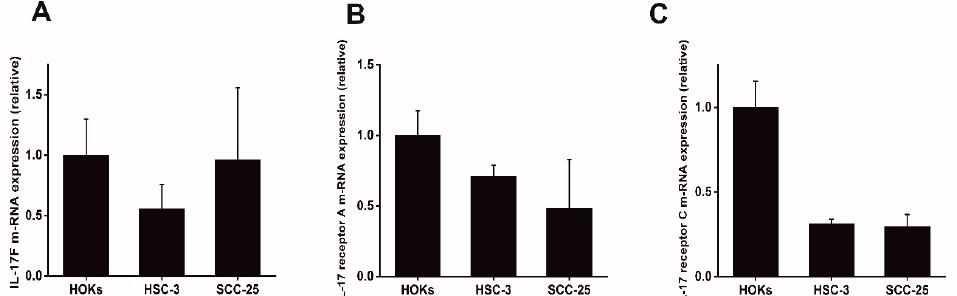
Figure 1. Expression of IL-17F and its receptors in oral tongue squamous cell carcinoma (OTSCC) cells. ( A ) Compared with normal human oral keratinocytes (HOKs), IL-17F mRNA was downregulated in highly invasive HSC-3 cells. ( B ) IL-17F receptor A mRNA was highly decreased in OTSCC cell lines compared to normal controls. ( C ) IL-17F receptor C mRNA was highly decreased in OTSCC cell lines compared to normal controls. Data are presented as means ± standard deviations.